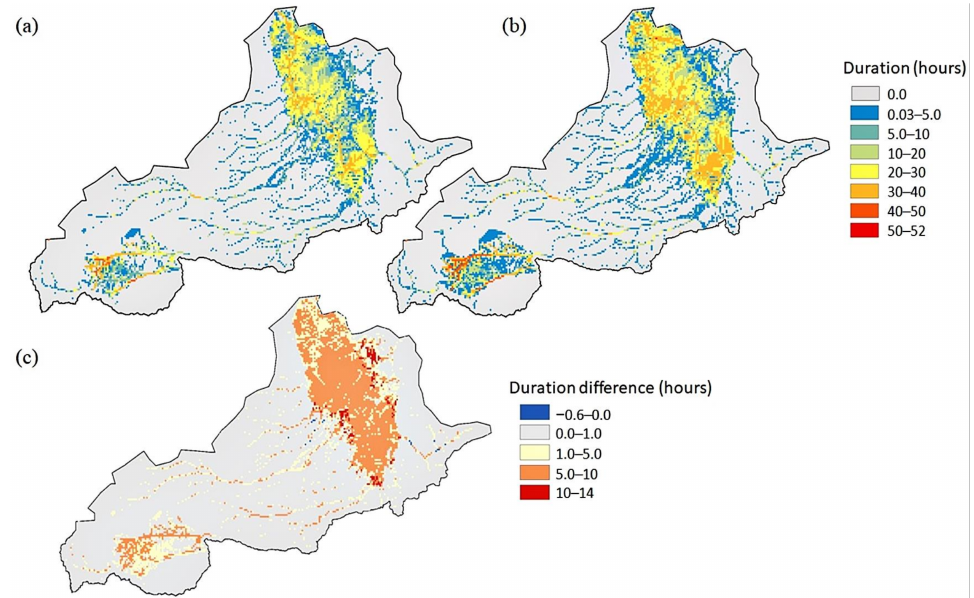
Figure 9. Spatial distribution of inundation durations averaged for ( a ) the top 20 rainfall events (historical simulation), ( b ) the top 36 rainfall events (future simulation), and ( c ) inundation duration differences between the top 20 past and top 36 future rainfall